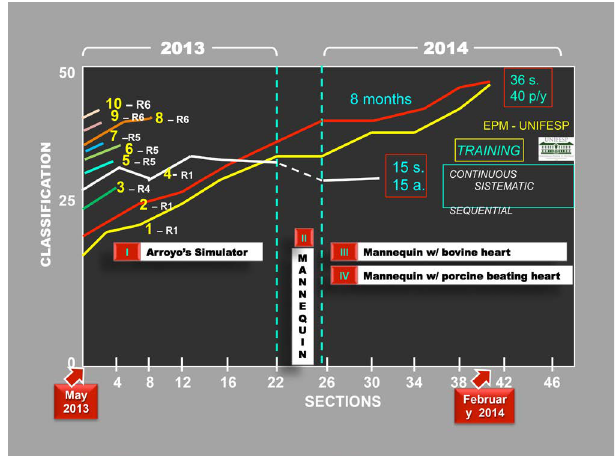
Fig.11 - Evolution of First Year Resident Training in Cardiovascular Surgery, with end-to-side coronary anastomosis using the Arroyo simulator.